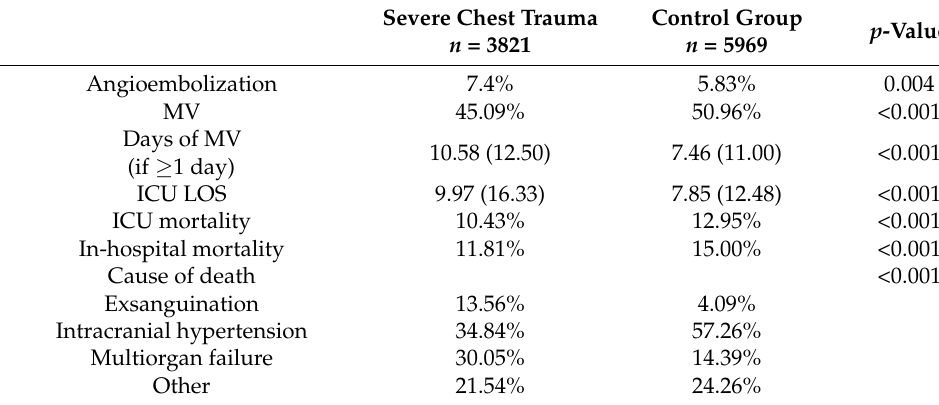
Table 5. Main outcomes in the severe chest trauma and control groups.